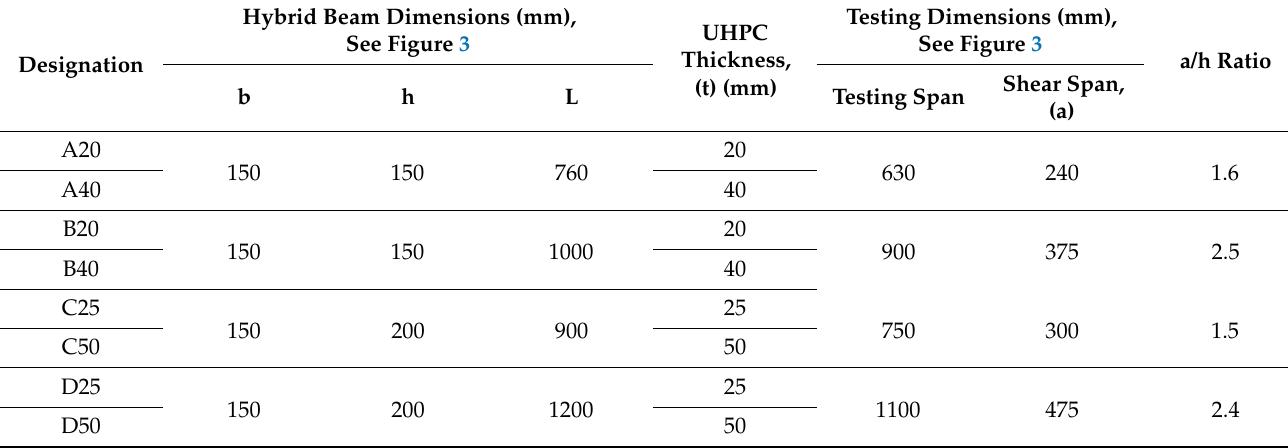
Table 4. Details of hybrid NC-UHPC